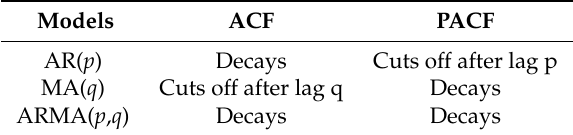
Table 1. Model Selection according to characteristics of ACF and PACF. ACF: autocorrelation function; PACF: partial autocorrelation function; AR: autoregressive; MA: moving